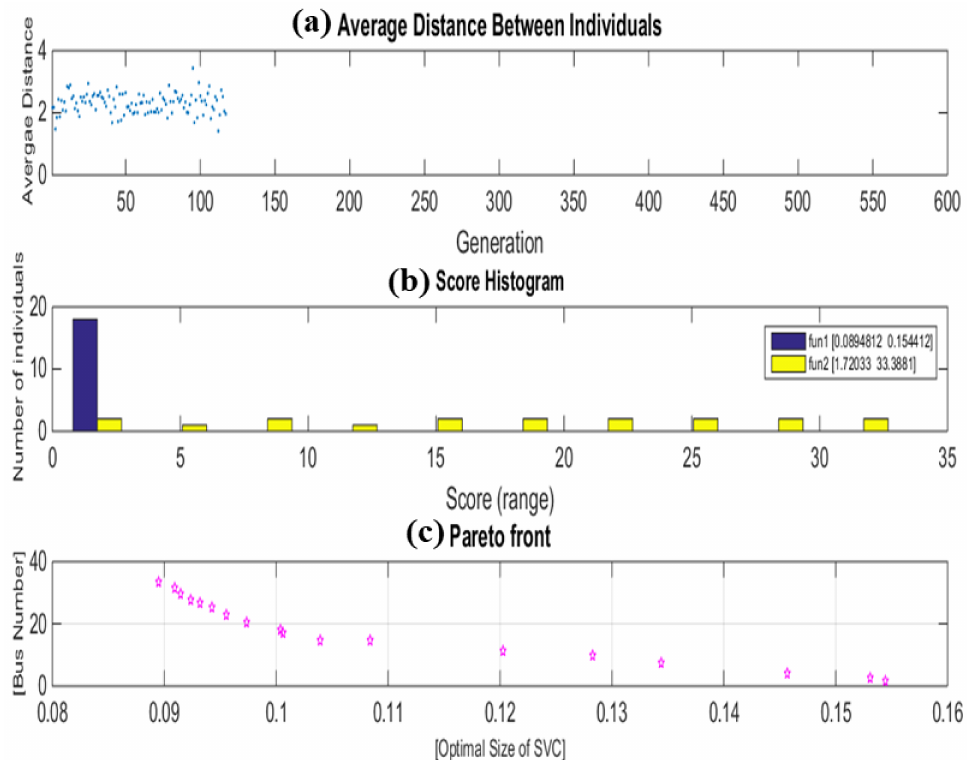
Figure 4. ( a ) Average distance between individual and generation, ( b ) Score histogram, ( c ) Pareto front for optimal solutions between the optimal size of SVC and bus